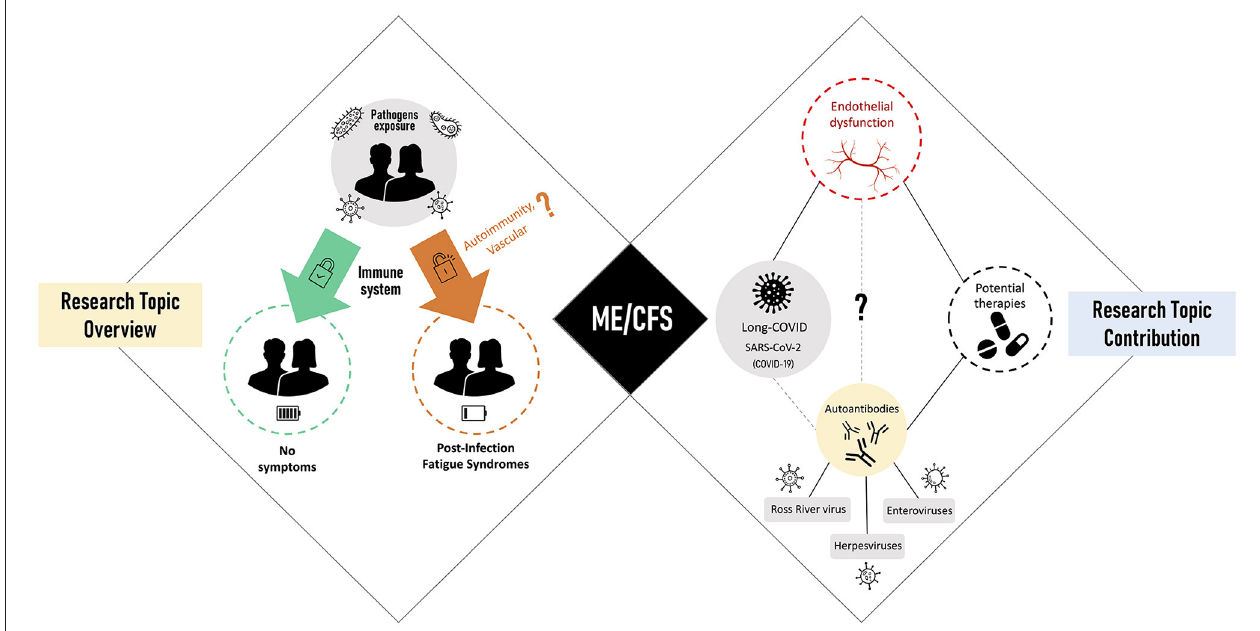
FIGURE 1 | Research Topic overview (left side) linked to post-infectious fatigue syndromes with myalgic encephalomyelitis/chronic fatigue syndrome (ME/CFS) as the main representative (center). Research Topic contribution (right) focused on viral triggers of ME/CFS, disease-related pathomechanisms, and potential